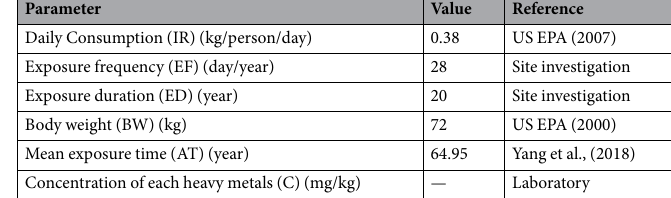
Table 2. Parameter for Annual Daily Dose computation.